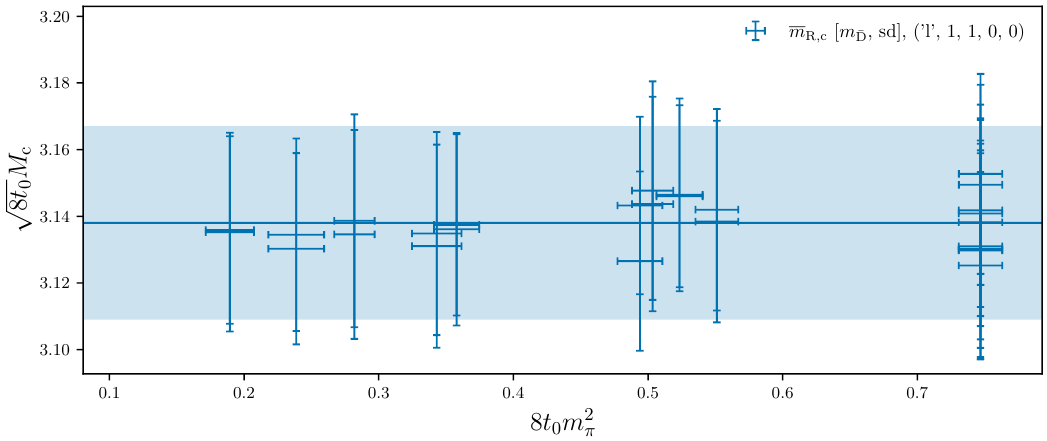
Figure 4 . Pion mass dependence and best chiral fit according to the AIC for the charm quark mass as defined in eq. (3.15). Note that φ is held constant along the chiral trajectory. To map out 4 a two-dimensional representation of the fit, other dependencies than the one illustrated in the plot have been projected to the physical point. The labelling convention is given in the